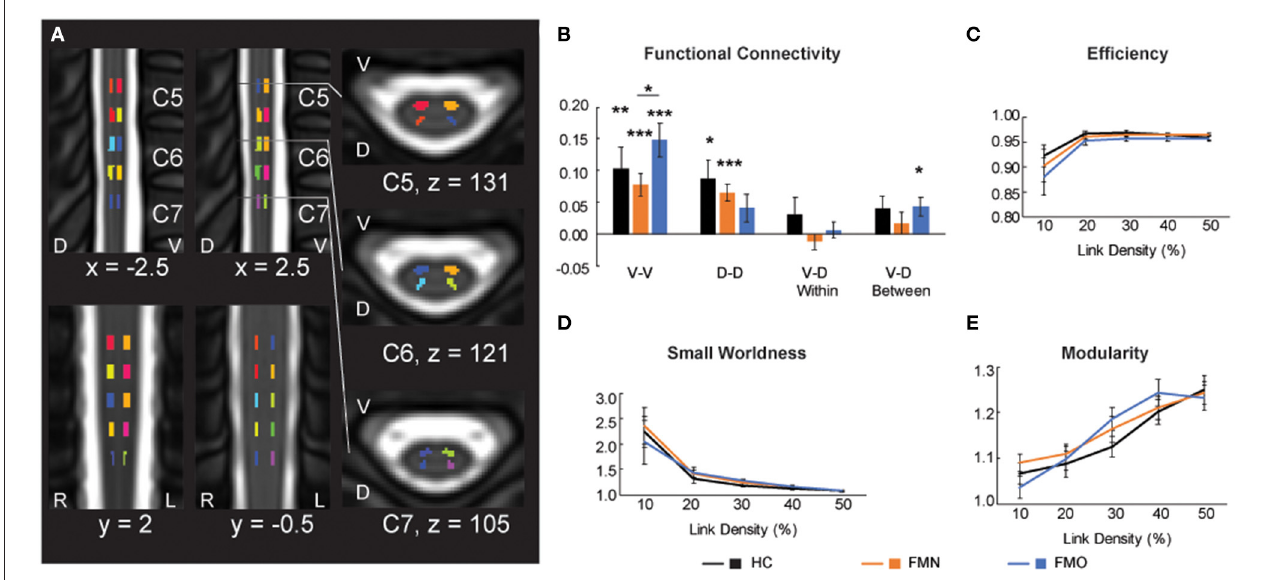
FIGURE 5 | Functional connectivity and graph metrics. (A) Colored regions indicate spinal cord regions of interest that were used for the functional connectivity and graph metric analyses. Reused and modified with permission from Martucci et al. (16). (B) Functional connectivity for ventral-ventral (V-V), dorsal-dorsal (D-D), ventral-dorsal within (V-D Within), and ventral-dorsal between (V-D Between). (C–E) Graph metrics of efficiency, small worldness and modularity across the three groups: healthy controls (HC), fibromyalgia patients not taking opioids (FMN), and fibromyalgia patients taking opioids (FMO). D, dorsal; L, left; R, right; V, ventral. * p < 0.05; ** p < 0.01; *** p <